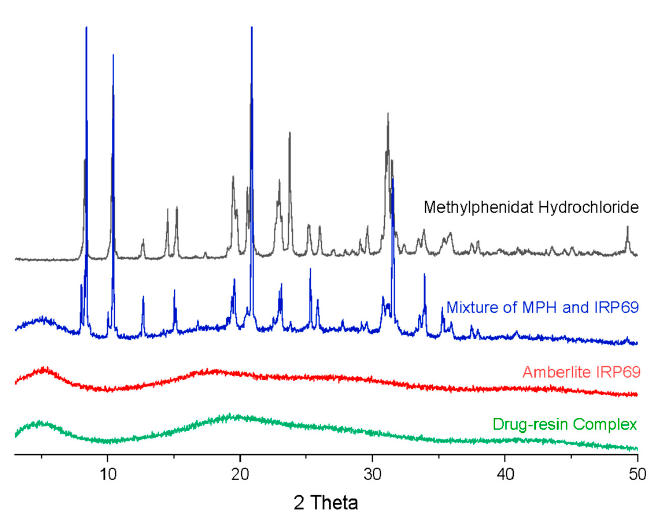
Figure 4. XRD patterns of methylphenidate hydrochloride, Amberlite IRP69, a mixture of methylphenidate hydrochloride and Amberlite IRP69, and drug–resin complex. The above research, in terms of morphology and crystal form, indicates the successful complexation of methylphenidate hydrochloride to resin, rather than simple physical mixing. Similar phenomena also occur in the compounding process of other drugs and ion exchange resins [18,28]. The results show that there is a certain interaction between the drug and the ion exchange resin, which significantly changes the original physicochemical properties of the